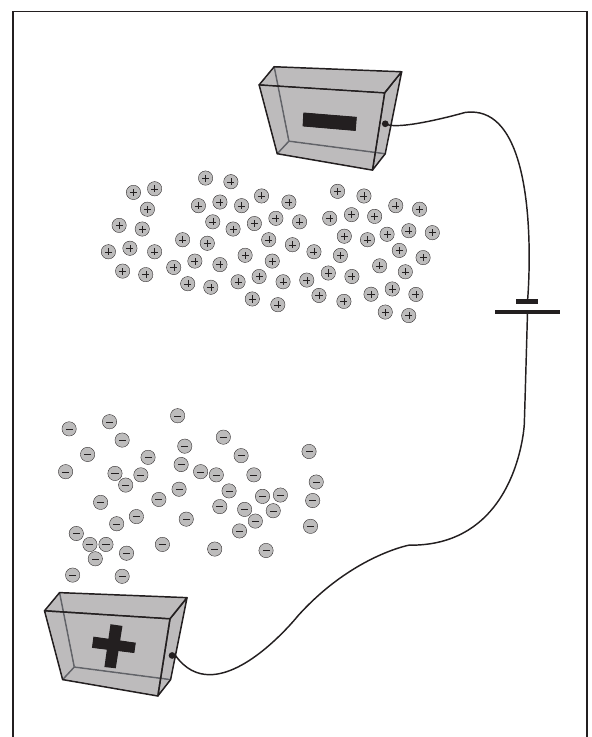
Figure 3 - Illustration of reverse iontophoresis effect over ionized substances. With application of a contin- uous current, substances with opposite polari- ties attract to each other